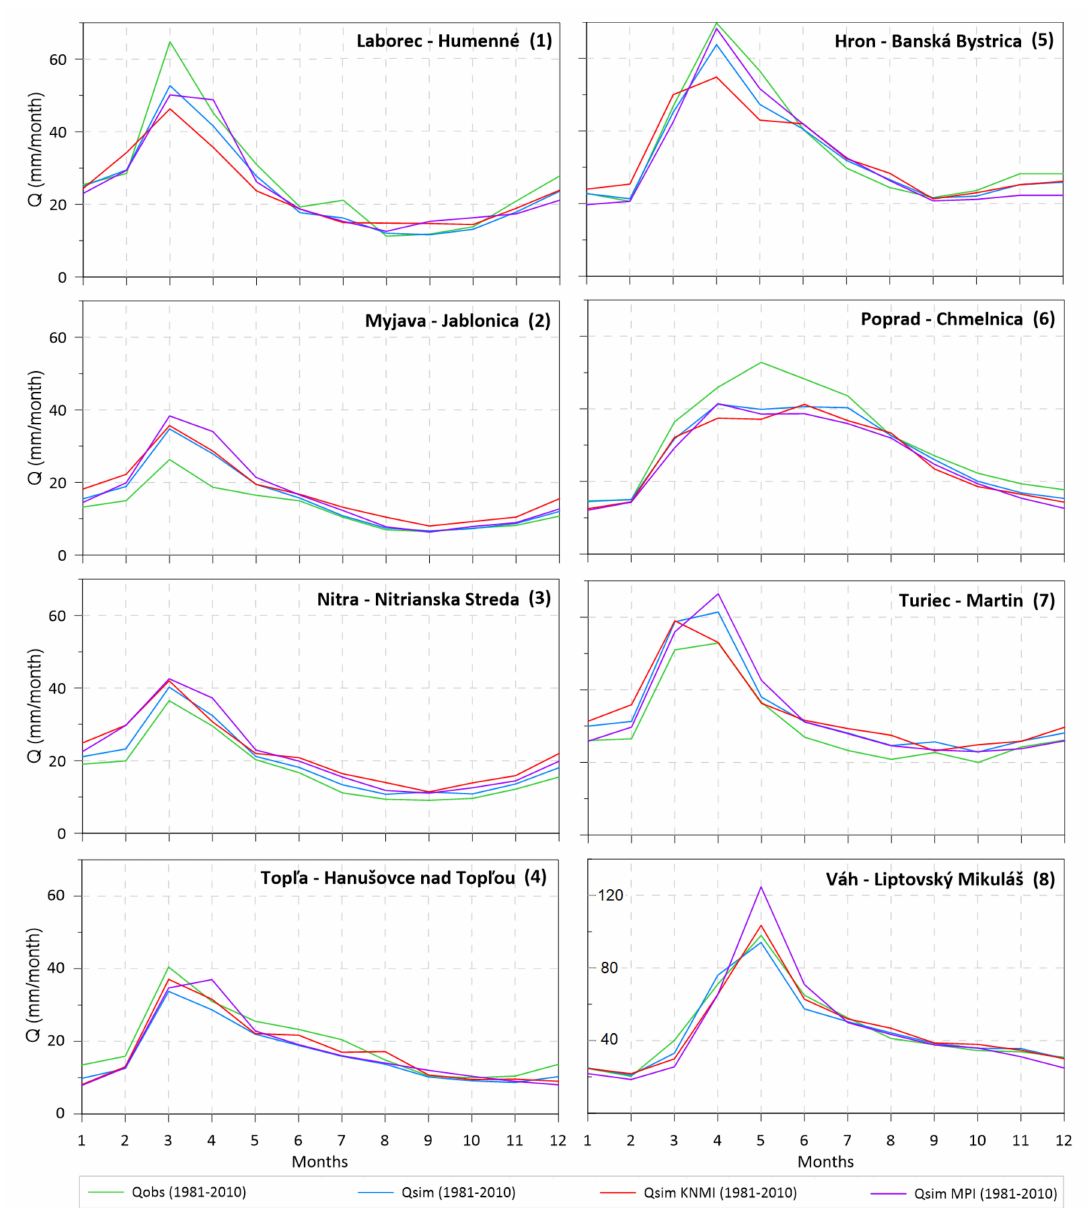
Figure 5. Comparison of the measured and simulated long-term mean monthly runoffs for the reference period (1981–2010) and for the two groups of river